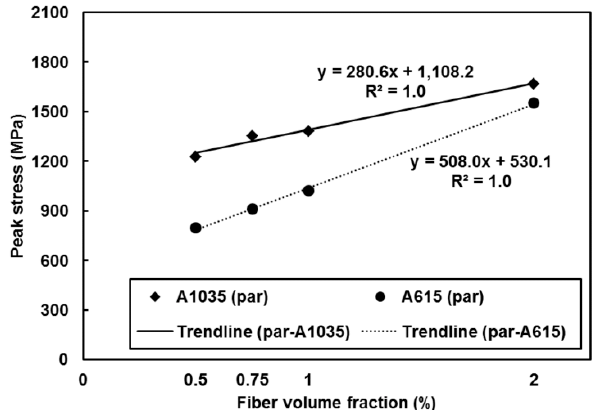
Figure 15. Effect of rebar type on the tensile behavior (parallel fiber orientation).